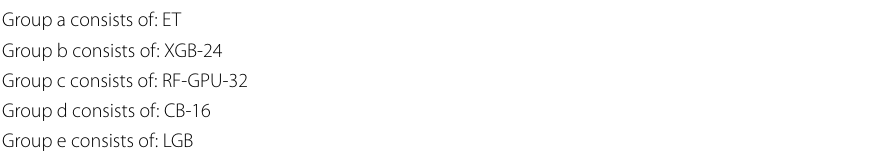
Table 30 HSD test groupings after ANOVA of AUPRC for the CLF factor